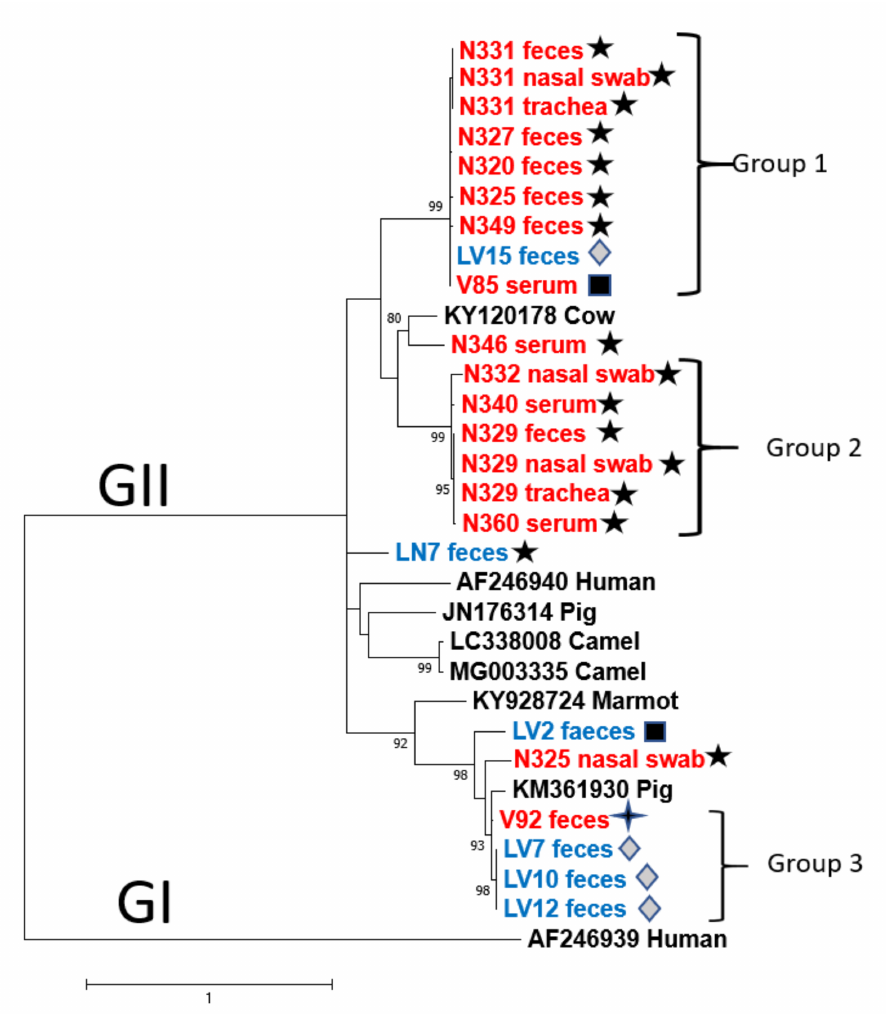
Figure 4. Phylogenetic analysis of partial RdRp gene of PBVs GII discovered in the present study. The tree was constructed using the maximum-likelihood method and the optimal substitution model of GTR+G+I and rooted with GII human strain AF246940. One hundred and ninety-three nucleotide positions were included in the analysis. Bootstrap values below 70% are not shown. Deer sequences are highlighted in red and cattle sequences in blue. ★ indicates samples collected in